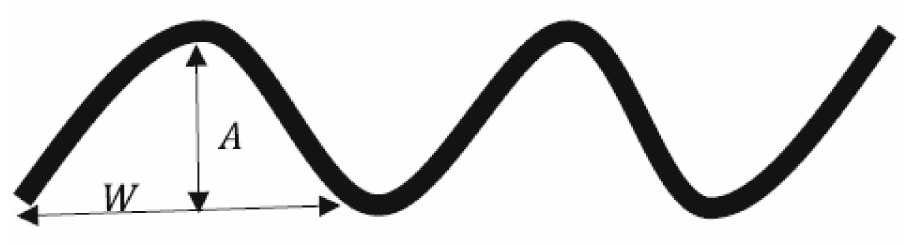
Figure 2. The schematic model of the wavy MWCNT